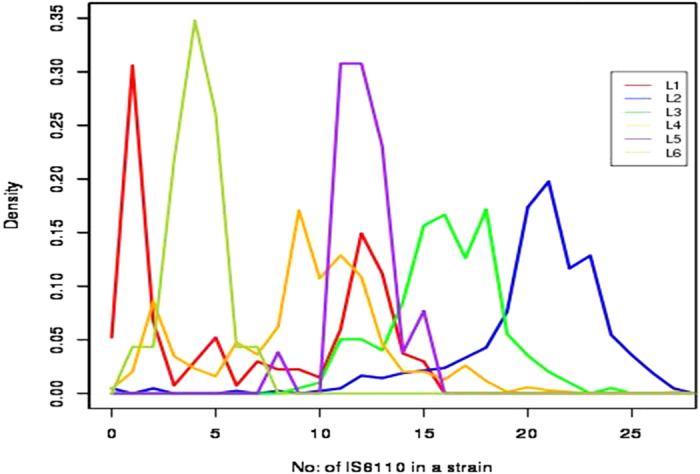
Lineage based IS6110 copy number distribution in six major global lineages of M.
tuberculosis.Each lineage is represented by a different color as mentioned in the box.